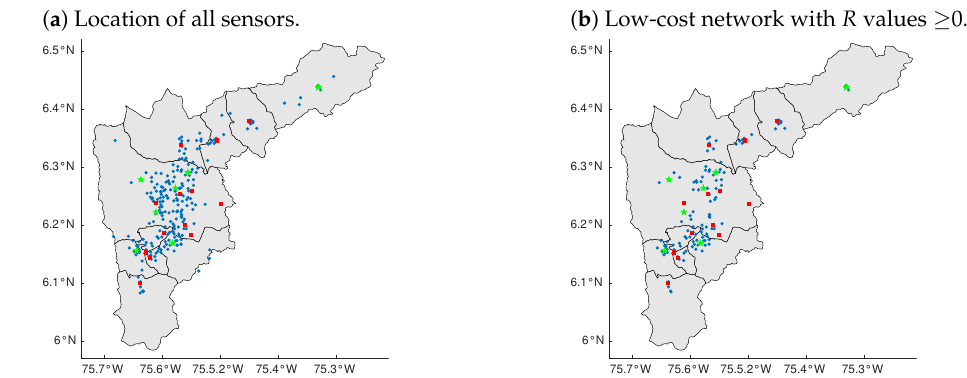
Figure 6. Spatial distribution of the different sets of sensors (complete network ( a ) and high-quality network ( b ) ) used for data assimilation and validation. Blue dots indicate the location of the low-cost sensors. Red squares correspond to the locations of the official monitoring stations that were used for data assimilation. Green stars indicate the stations from the official network whose data where used for validation of all model